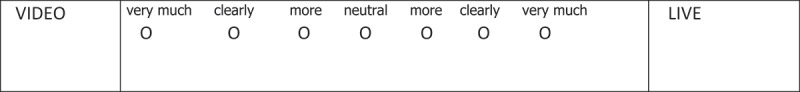
Bipolar rating scale.